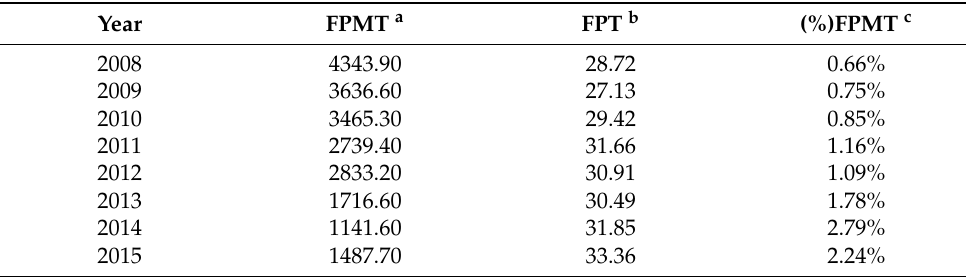
Table 3. Carbon footprint of the Spanish ports tugboat fleet and its contribution to the carbon footprint of the Spanish marine transport sector (2008–2015).